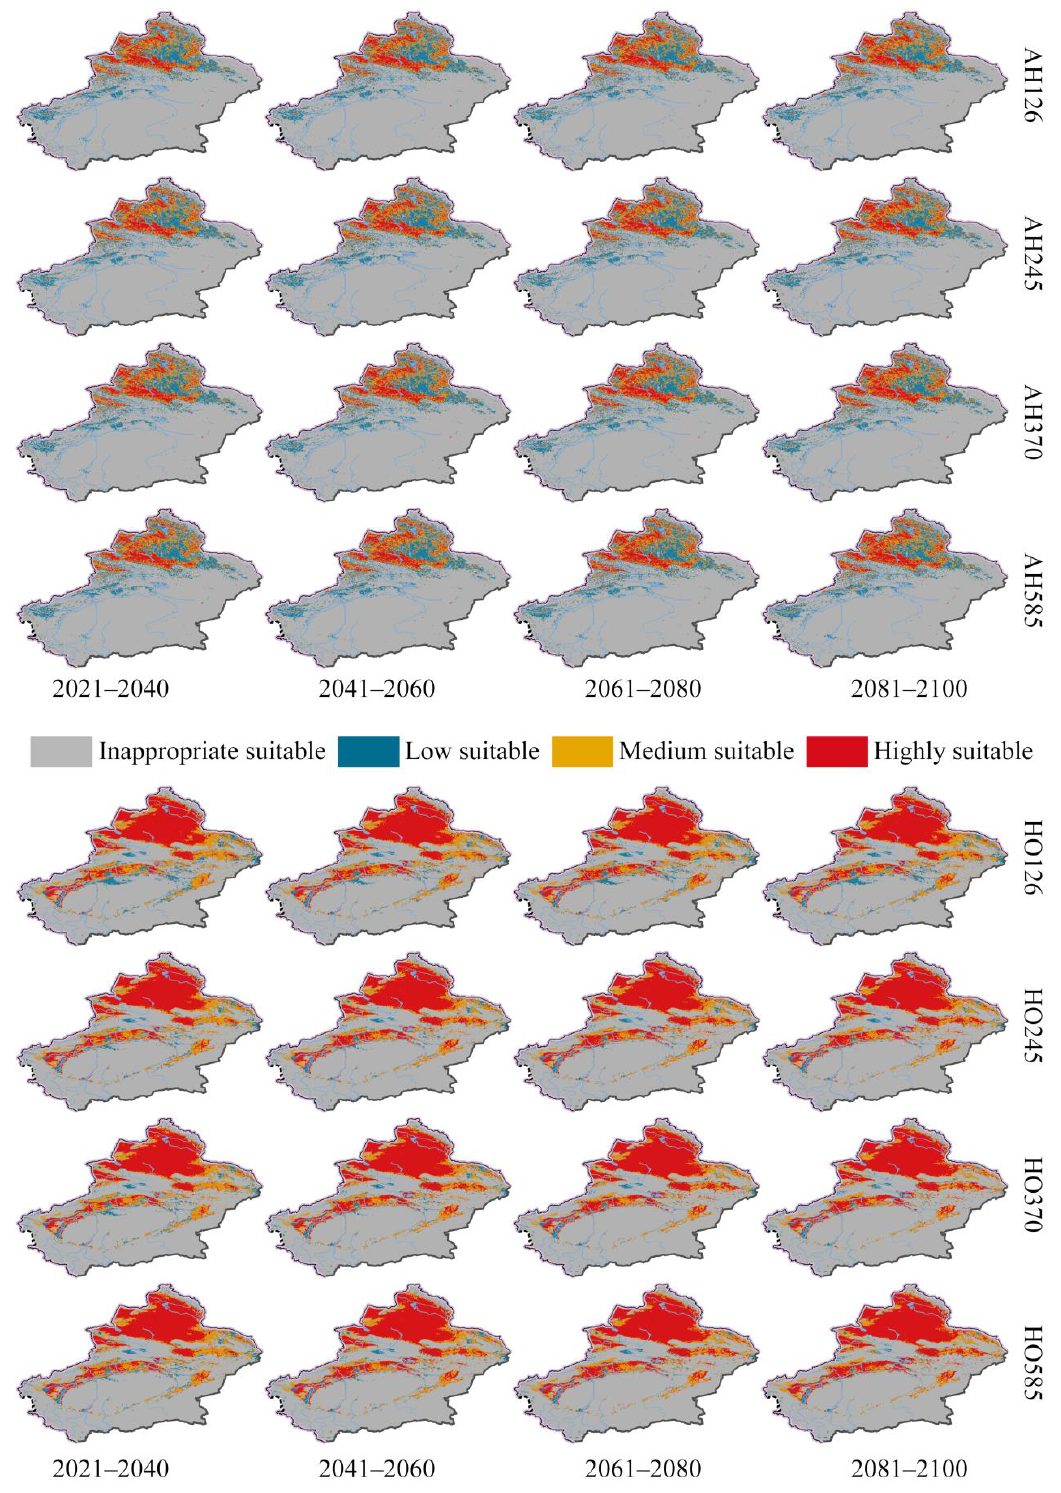
Figure 4. The distributions of C. deserticola in climate scenarios. The AH/HO means the strategy of abiotic and host factors or host factors only. And the number 126/245/370/585 means the Shared Socio-economic Pathways.